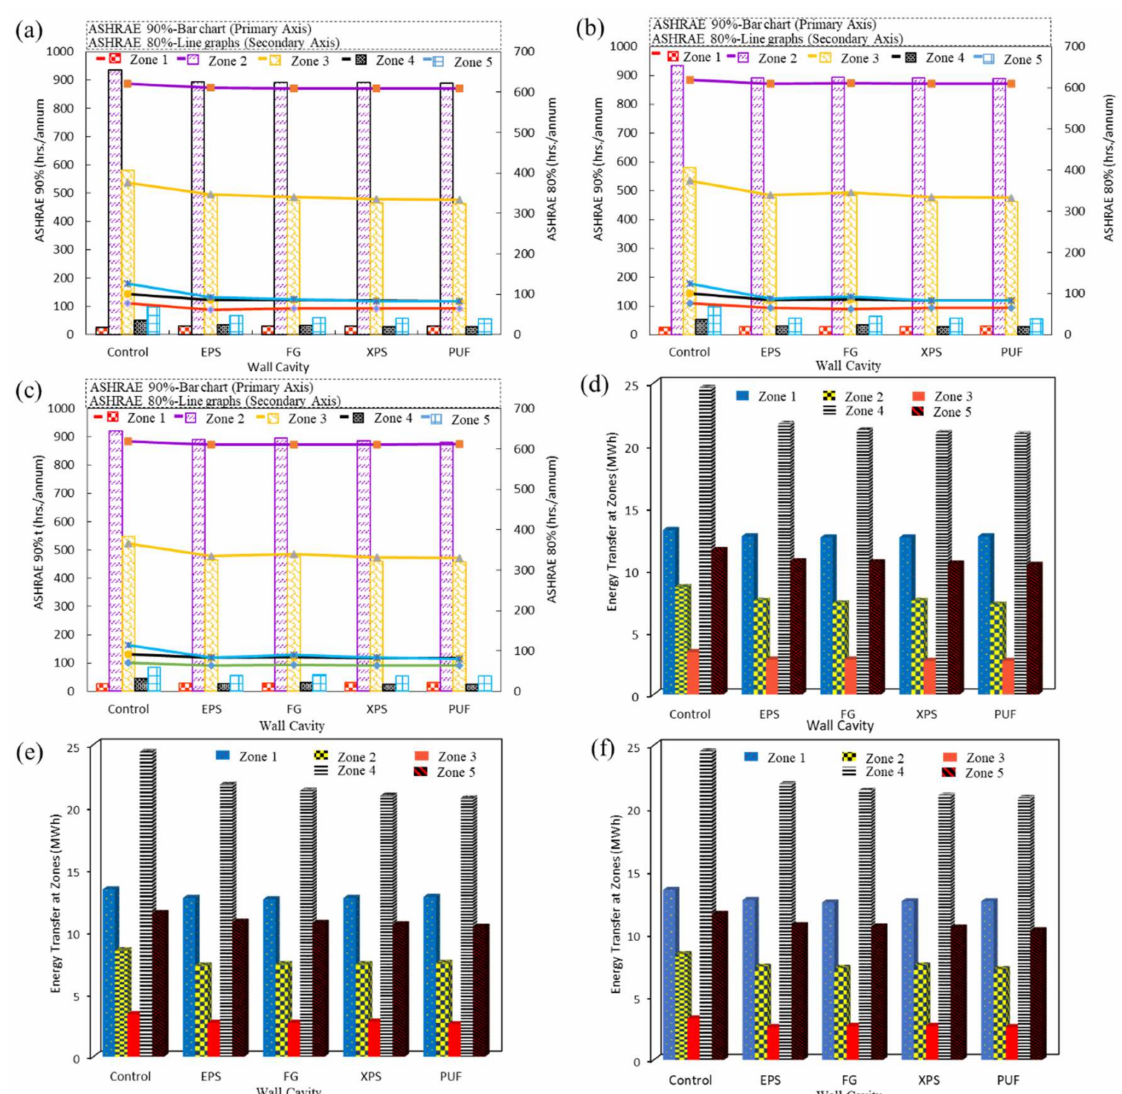
Figure 5. Performance of insulated 3DPC at ASHRAE thermal comfort acceptability limits for ( a ) Mix 1; ( b ) Mix 2; ( c ) Mix 3. Insulation effects on thermal energy transfer of 3DPC Walls for ( d ) Mix 1; ( e ) Mix 2; ( f ) Mix